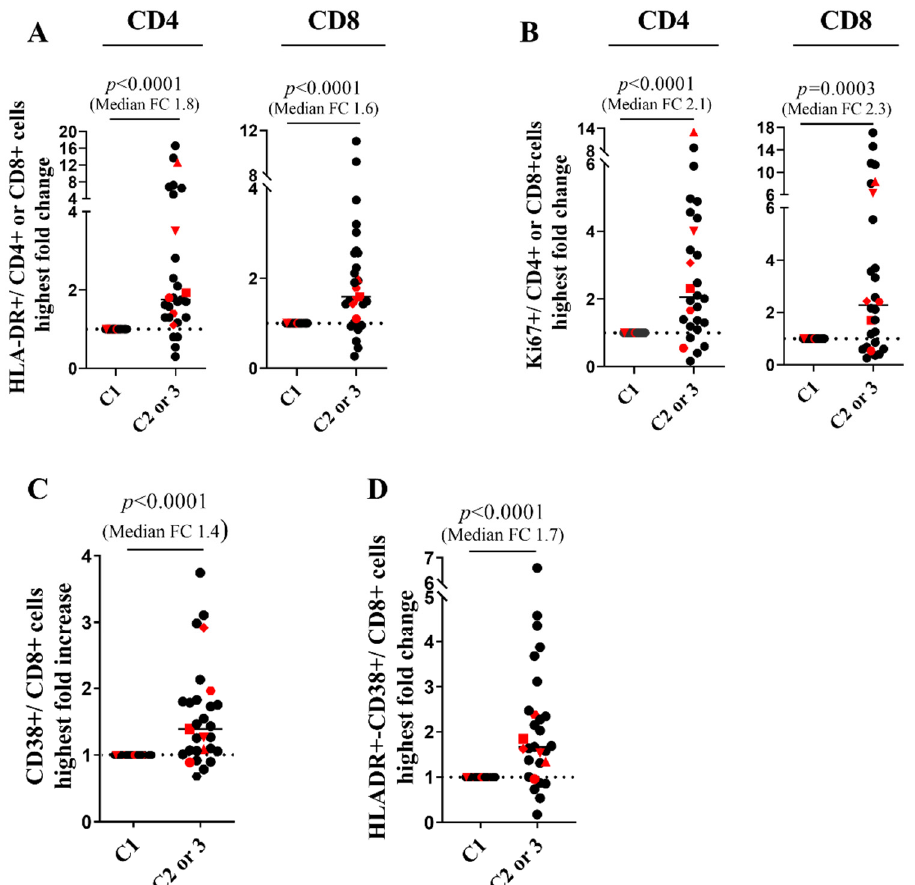
Figure 2. Anti-PD-1 treatment in PLWH with cancer results in T cell immunological activation. ( A ), Highest fold change at C2 or 3 from baseline in HLA-DR + cells among CD4+ and CD8 + T cells. ( B ), Highest fold change at C2 or 3 from baseline in Ki67+ cells among CD4+ and CD8+ T cells. ( C ), Highest fold change at C2 or 3 from baseline in CD38+ cells among CD8+ T cells. ( D ), Highest fold change at C2 or 3 from baseline in CD38 + HLA-DR + cells among CD8 + T cells. Red spots denote the RR patients and dotted lines denote fold change of 1. Wilcoxon- signed Rank test. FC: fold change. Experiments were monoplicates.